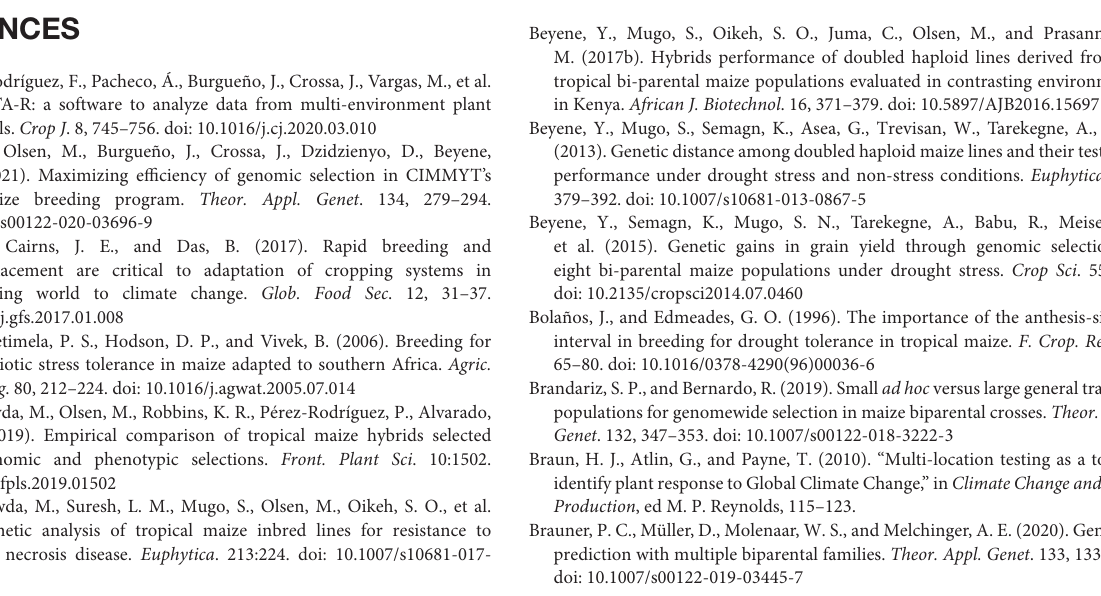
Supplementary Figure 1 | Three-dimensional plot based on three eigenvectors of genotypic data to show the genetic relationship among the 3 years data set used in the